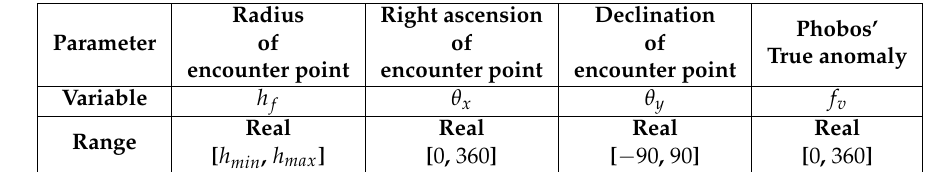
Figure 11. The gene map of the hyperbolic trajectory design problem describing the different design variables and their bounds.